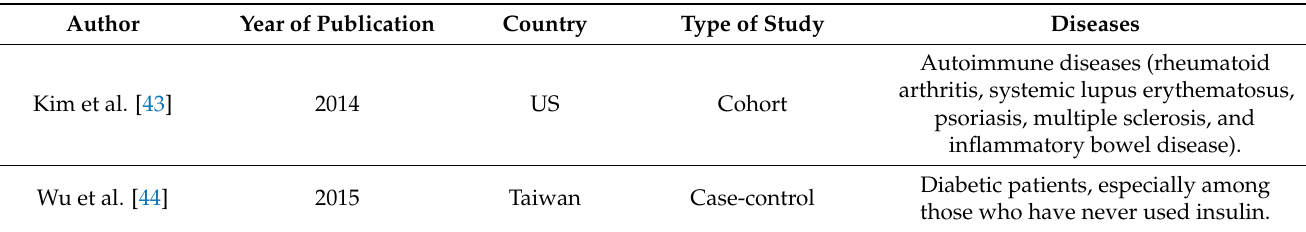
Table 2. Studies about the occurrence of psoriasis in other